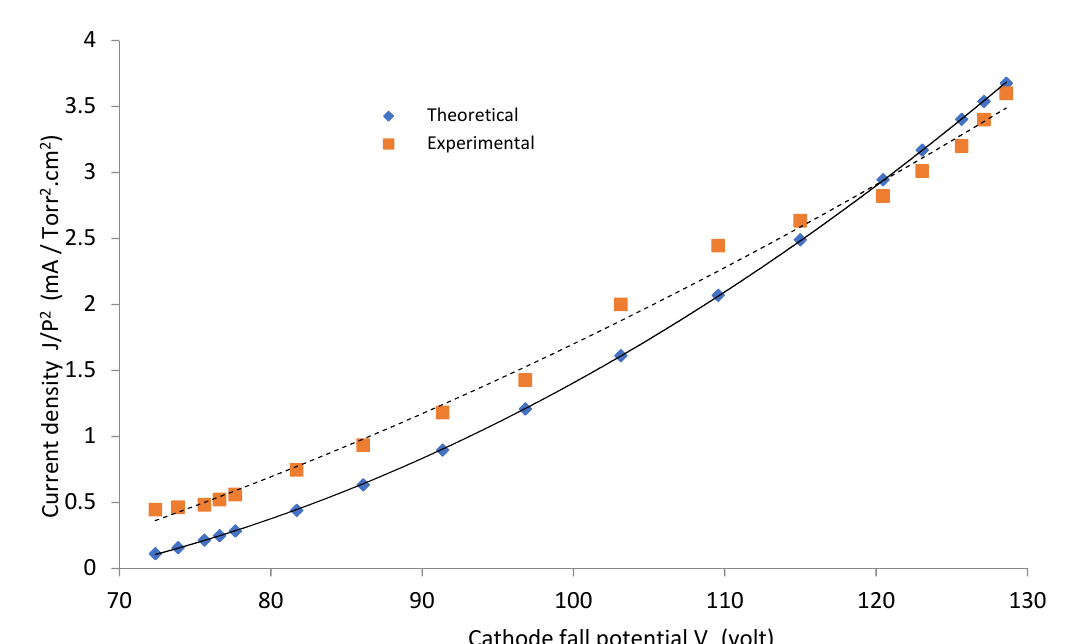
Figure 6. Current density as a function of the cathode fall potential for OMSE with applied pressure of 1 mTorr.